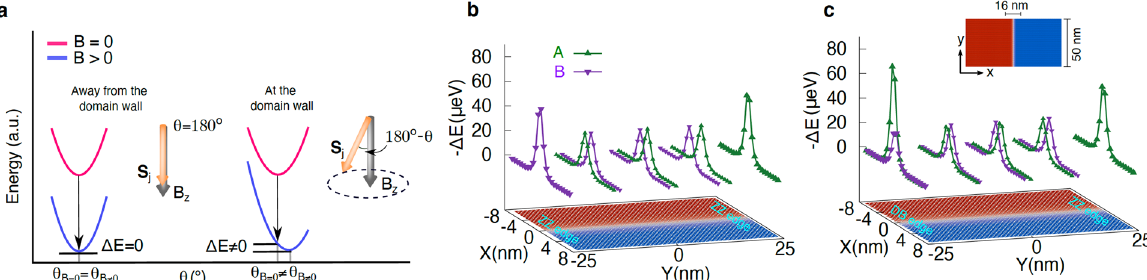
Fig. 6 Sublattice energetics. a Diagram of the energy versus the angle θ de fi ned relative to the z -axis. Away from the domain wall, θ can be either 0 o or 180 o depending on what sublattice is considered. At the wall, θ can range within 0 – 180 o for one sublattice, and 180 – 0 o for the other. B z points along of z < 0. Spins at the wall (0 o < θ < 180 o , which excludes fully spin-up and spin-down states) react differently than those away from the wall (i.e., θ = 0 for spin-up or theta = 180 o for spin down) to an external magnetic fi eld. Only for those at the wall, a fi nite B z changes the energetic stability of the system inducing a rotation of the spins as the magnitude of θ changes to an additional energy minimum ≠ θ Δ E shows the energy gained through a rotation to the additional minimum once the fi eld is applied. For the spins away (e.g., θ B B z ≠ 0 ). z ¼ 0 from the wall, B z causes a rigid shift of the energy curve while preserving its shape. This results in no change in the value of θ for the minimum energy, and thus, no rotation induced locally by the magnetic fi eld. The energy is calculated via Eq. (8). b , c Plots of − Δ E for few atoms at different regions of the layer such as at the edges, near the edges and middle of the sheet for systems with ZZ-ZZ and ZZ-DB edges, respectively. The different sublattices (A and B) are shown individually in different colored curves. We plot − Δ E instead of Δ E to better display the variations of energy at different parts of the system. The inset in f shows a side view of the layer with the dimensions considered in the